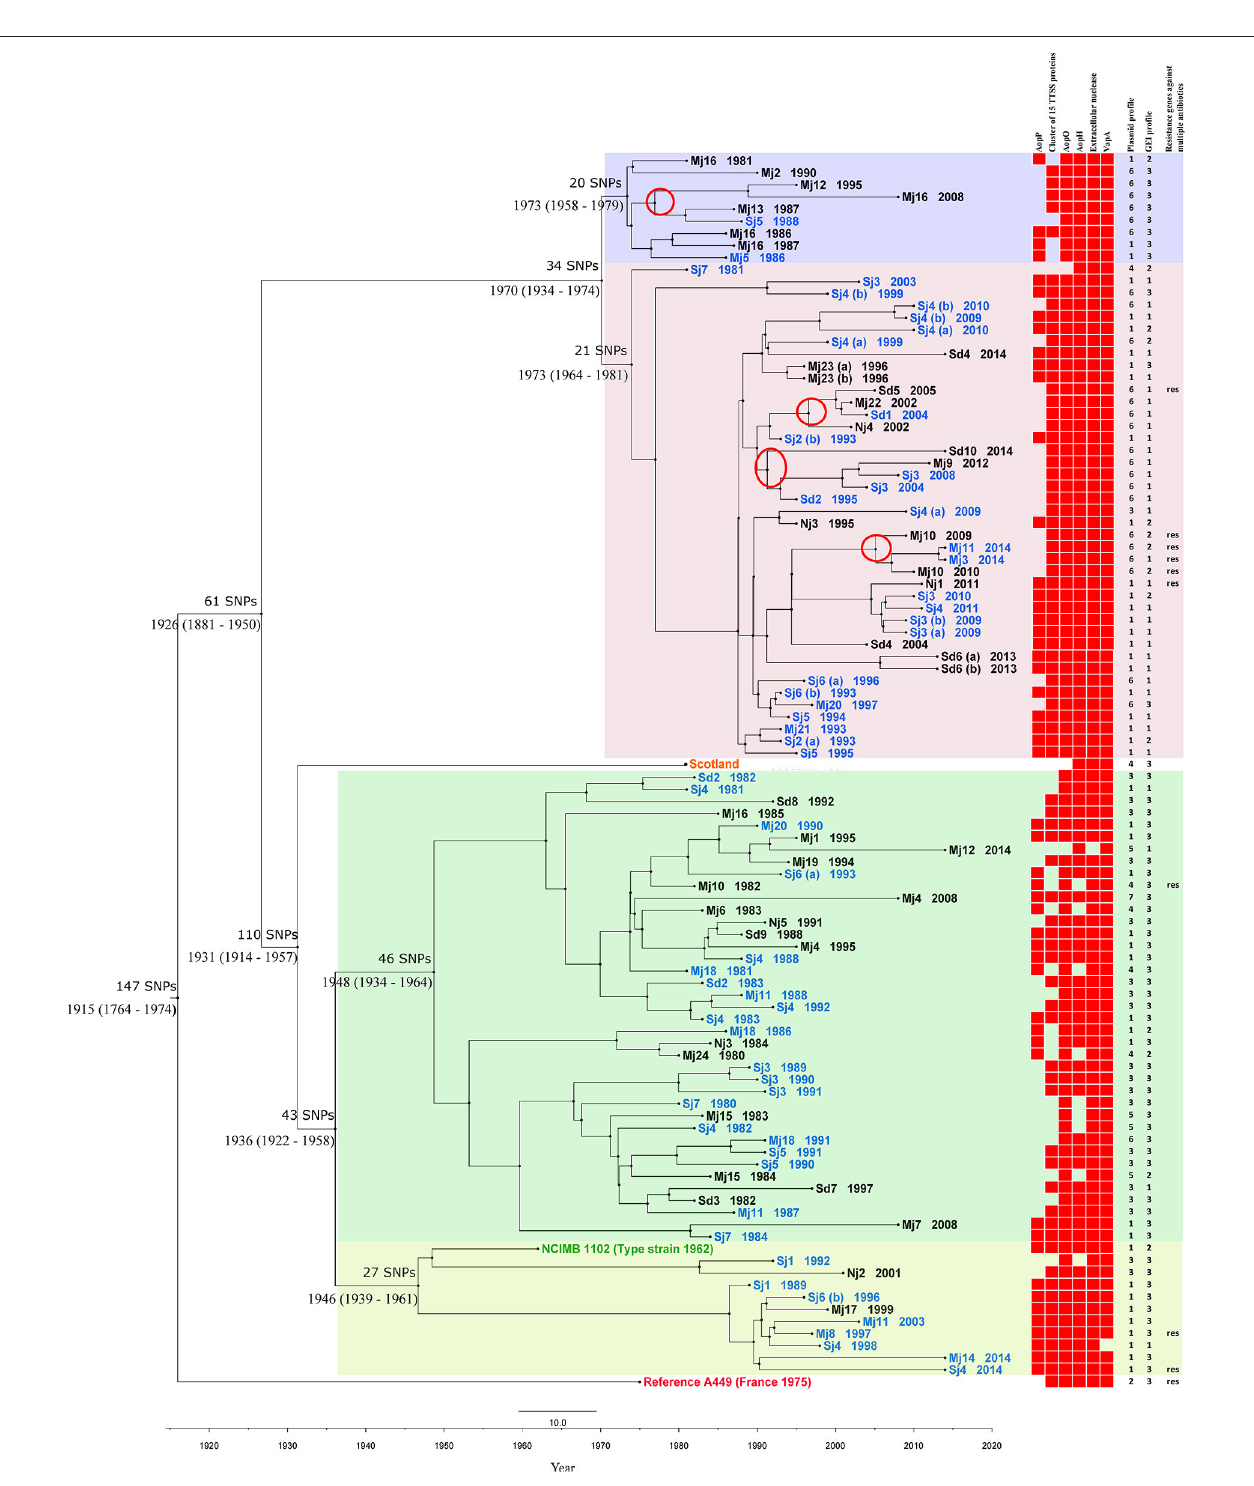
FIGURE 1 | Phylogeny of A. salmonicida subsp. salmonicida . Bayesian temporal phylogenetic tree based on the alignment of 667 SNPs found among the 101 A. salmonicida subsp. salmonicida sequenced isolates and the reference A449. The tree shows the most recent common ancestor of the A. salmonicida subsp. salmonicida isolates dates back to ∼ 1915 (95% HPD interval 1764–1947) and that there have been four main introductions of A. salmonicida subsp. salmonicida in Denmark: ∼ 1973 (95% HPD interval 1958–1979), ∼ 1973 (95% HPD interval 1964–1981), ∼ 1948 (95% HPD interval 1934–1964) and ∼ 1946 (95% HPD interval 1939–1961). The four main clades are each shaded with a color SNP differences between major clades are shown above the estimated year of emergence. The three